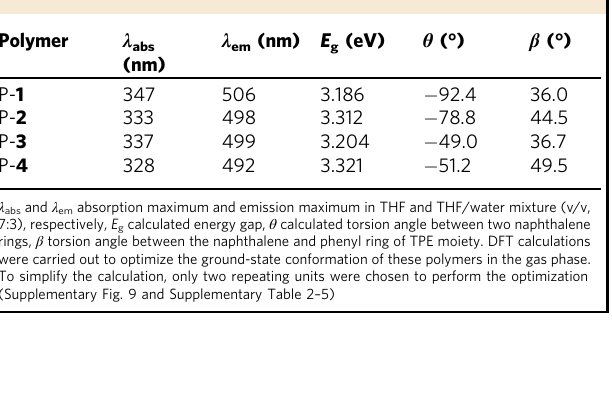
Table 1 Photophysical properties and simulation results. Calculated by B3LYP/6-31 G(d), Gaussian 09